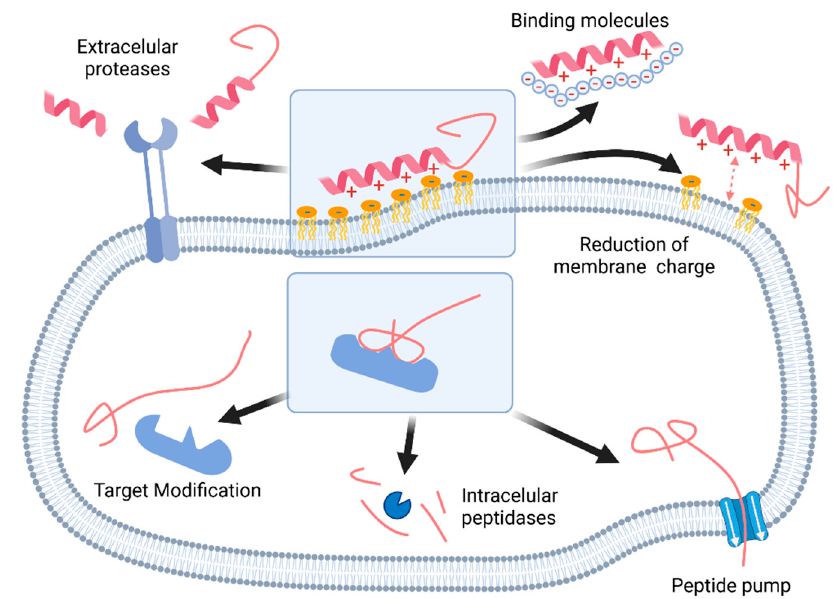
Figure 2. Mechanisms of resistance to host-defense peptides. Created with BioRender.com (accessed on 27 June 2022 )